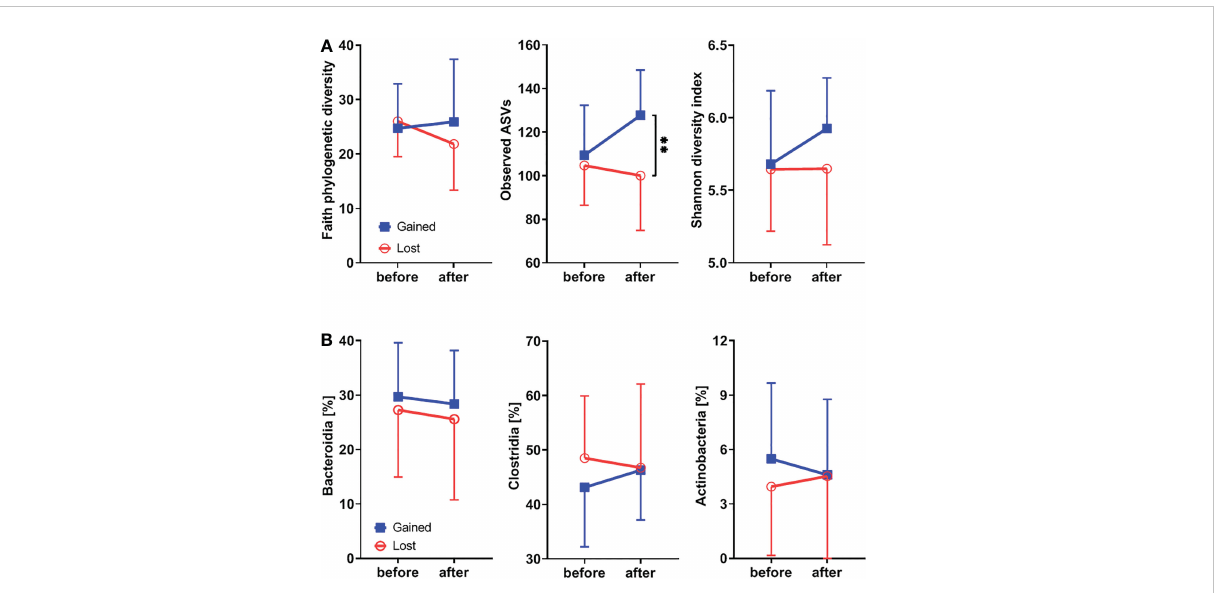
FIGURE 5 Hormonal gains lead to increased a -diversity and Clostridia abundance, while classes Bacteroidia and Actinobacteria are decreasing. (A) Comparison of changes in a -diversity characterized by Faith ’ s phylogenetic diversity, observed features, or Shannon diversity index and analyzed by two-way ANOVA with Sidak ’ s multiple comparisons test in patients who lost natural hormones due to surgery (lost) with those who gained hormones due to hormonal therapy (gained). In the lost group, before = before surgery and after = 12 months after the surgery. In the gained group, before = before the hormonal therapy started and after = 12 months on hormonal therapy. (B) Comparison of changes in selected bacterial classes based on their relative abundance using the same time points as in a -diversity analysis. For a -diversity analyses, rarefaction was performed at 2,020 reads, and patients with lower yields in one time point were excluded from the analysis. ** p <